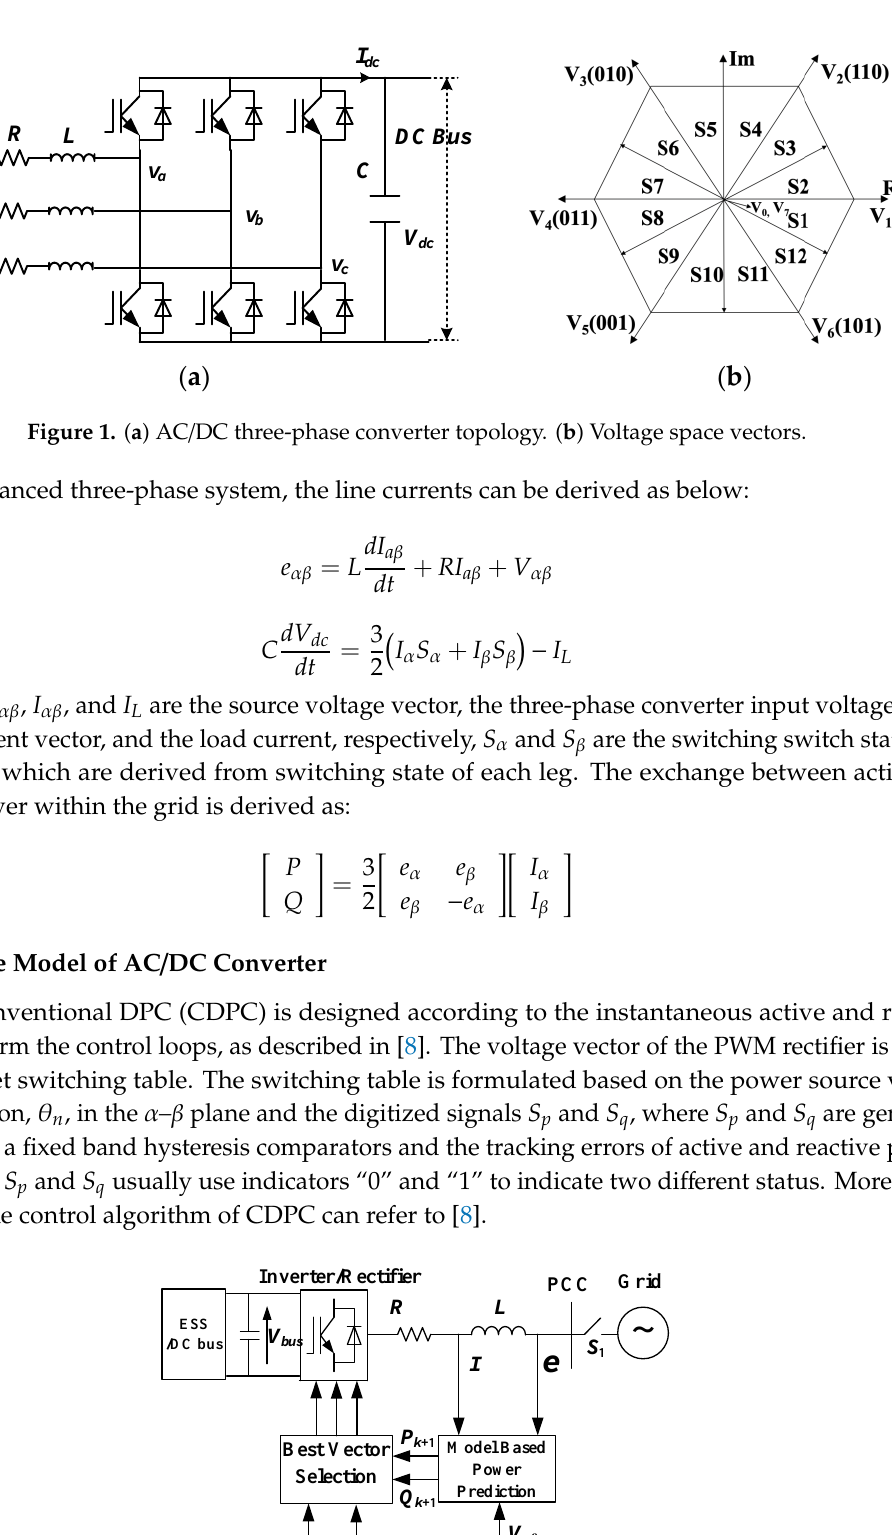
Figure 2. Block diagram of MPC-based power regulation.